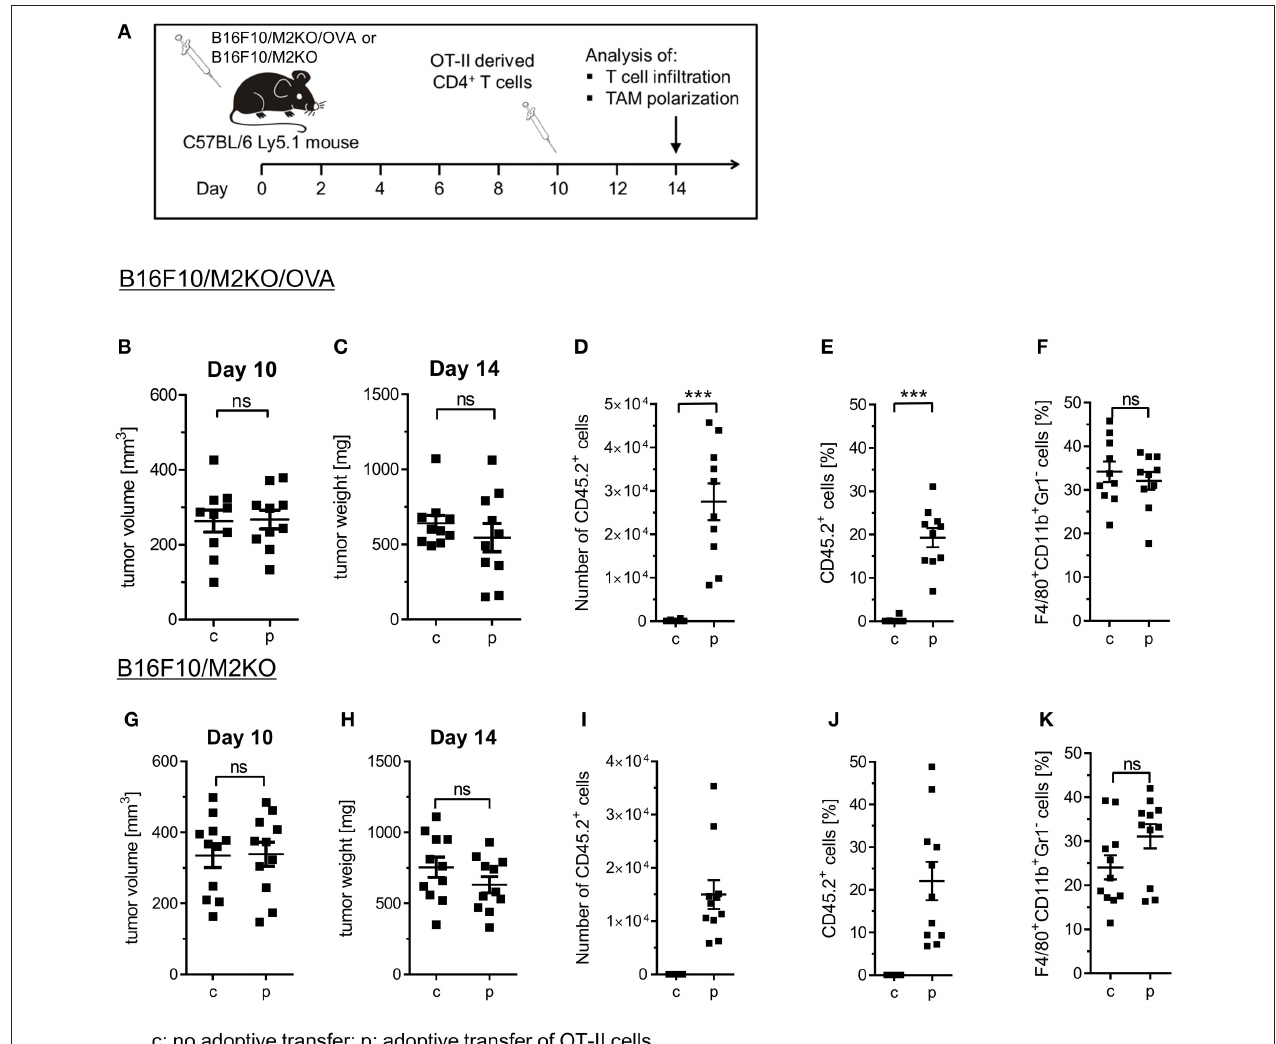
FIGURE 4 | Immune cell composition of B16F10/M2KO/OVA and B16F10/M2KO tumors after adoptive transfer of OVA specific CD4 + T cells. (A) Experimental workflow. C57BL/6 Ly5.1 mice ( n = 10–11) were injected s.c. with 2 × 10 5 B16F10/M2KO/OVA cells (B–F) or B16F10/M2KO cells ( G–K ) respectively. Ten days post tumor inoculation, mice were injected i.v. with 5 × 10 6 peptide activated OVA specific OT-II T cells (p), whereas control mice were left untreated (c). Mice were sacrificed on day 14 and tumors were analyzed by flow cytometry. Tumor volume (B,G) and tumor weight (C,H) determined 10 and 14 days, respectively, after tumor cell injection. The absolute numbers of infiltrating OT-II cells (D, I) as well as the proportion of adoptively transferred CD45.2 + OT-II cells among CD4 + CD8 − TILs (E,J) and of F4/80 + CD11b + Gr1 + TAMs among CD45 + cells (F,K) are shown. Statistical analysis was done by unpaired Student’s t -test (95% CI, ns: not significant, *** p ≤ 0.001). Gating strategy: CD45 + → living cells → single cells (FSC-A vs. FSC-H) → F4/80 + CD11b + Gr1 − or CD4 + CD8 − → CD45.1 vs